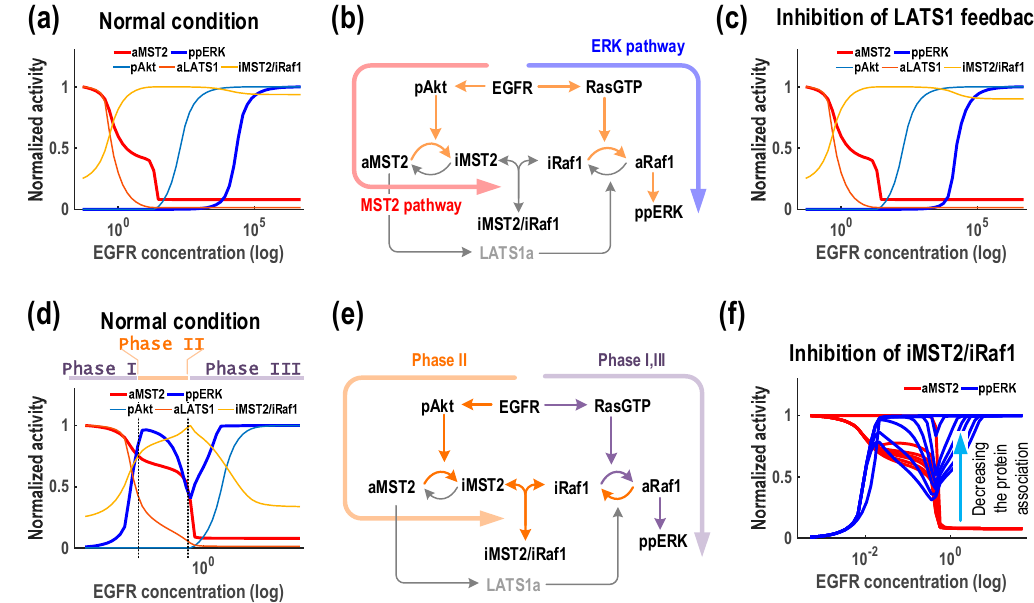
Figure 7. EGFR generates multi-phasic ERK response. ( a – c ) The pattern M 1 E 2 where EGFR robustly downregulates MST2 activity but increases ERK activity; ( d – f ) The pattern M 1 E 4 where the activation of ERK shows an initial increase (Phase I) at low EGFR, followed by a decrease (Phase II) at intermediate EGFR levels, but bounced back (Phase III) again at high EGFR levels. The association coefficient between Raf-1 and MST2 was gradually blocked and the temporal decrease pattern of the activation of ppERK disappeared accordingly (indicated by the arrow, right panel). Note that the response profiles to EGFR were generated using a representative parameter set that show the same patterns as in Figure 4 (see Supplementary Materials Table S4).